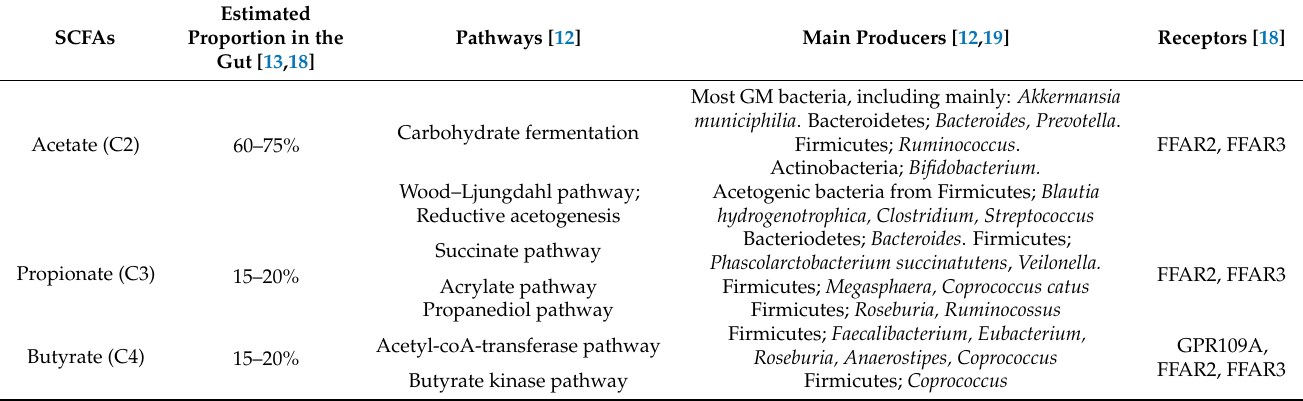
Table 1. Major types of SCFA from